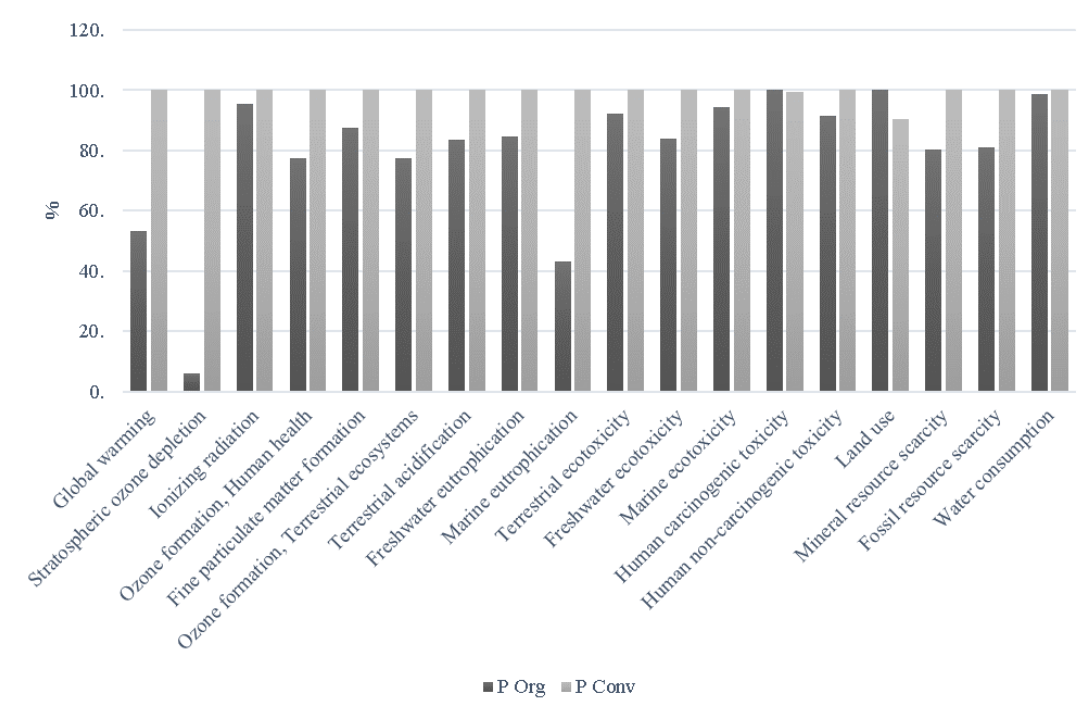
Figure 2. Impact comparison of organic and conventional production of the early potato (% of average value for each category). Table 5. Characterization factors and environmental impact per kg of early organic and conven- tional potatoes (*).